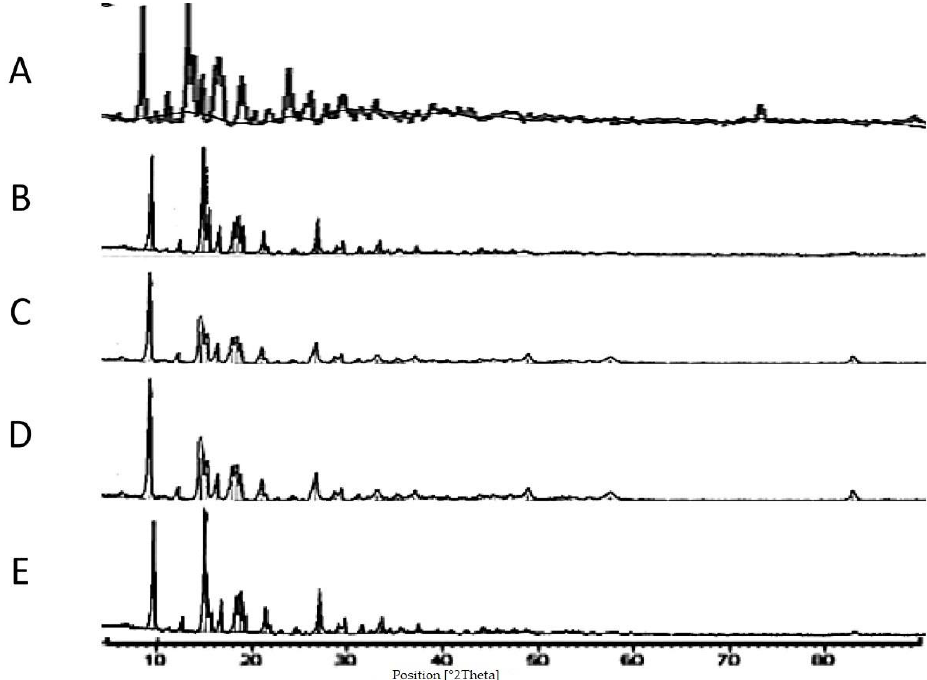
Figure 8. XRD scans of different TAA formulations. ( A ) Micronized TAA raw material unprocessed and ( B ) 1% ( w/v ) TAA/ammonium bicarbonate (90:10), ( C ) (85:15), and ( D ) (80:20) and ( E ) 1.5 ( w/v ) % TAA/ammonium bicarbonate (90:10) products spray-dried from 90% ( v/v ) ethanol. Particle size was determined using SEM (Table 4). Micronized TAA had an average particle size <5 µm while the mean particle size for the 1% TAA/ABC solutions in 90% ethanol v/v was 2.26 ± 0.36 µm, 2.45 ± 0.24 µm, and 3.00 ± 0.49 µm for 10, 15, and 20% ABC solutions, respectively. The particle size of the 1.5% TAA from the 10% ABC spray-dried formulation was 2.55 ± 0.65 µm. Table 4. Physical examination results of TAA spray-dried products with ABC blowing agent in comparison with micronized TAA. D ( um ) 0.00 D, diameter of sphere representing particle size; ρb , bulk density; ρt , tapped density; C, Carr’s index ; SE, standard error. The bulk ( ρb ) and tapped ( ρt ) densities and Carr ’ s index of TAA/ABC formulations are summarized in Table 4. The calculated Carr ’ s index for the spray-dried TAA/ABC for- mulations indicated the improvement of powder flowability compared to micronized TAA. 3.3. Selection of the Appropriate Formula for In-Vivo Studies According to the described results, the feasibility of the preparation of an additive- free TAA spray-dried product was confirmed. This conclusion was evidenced by the non-